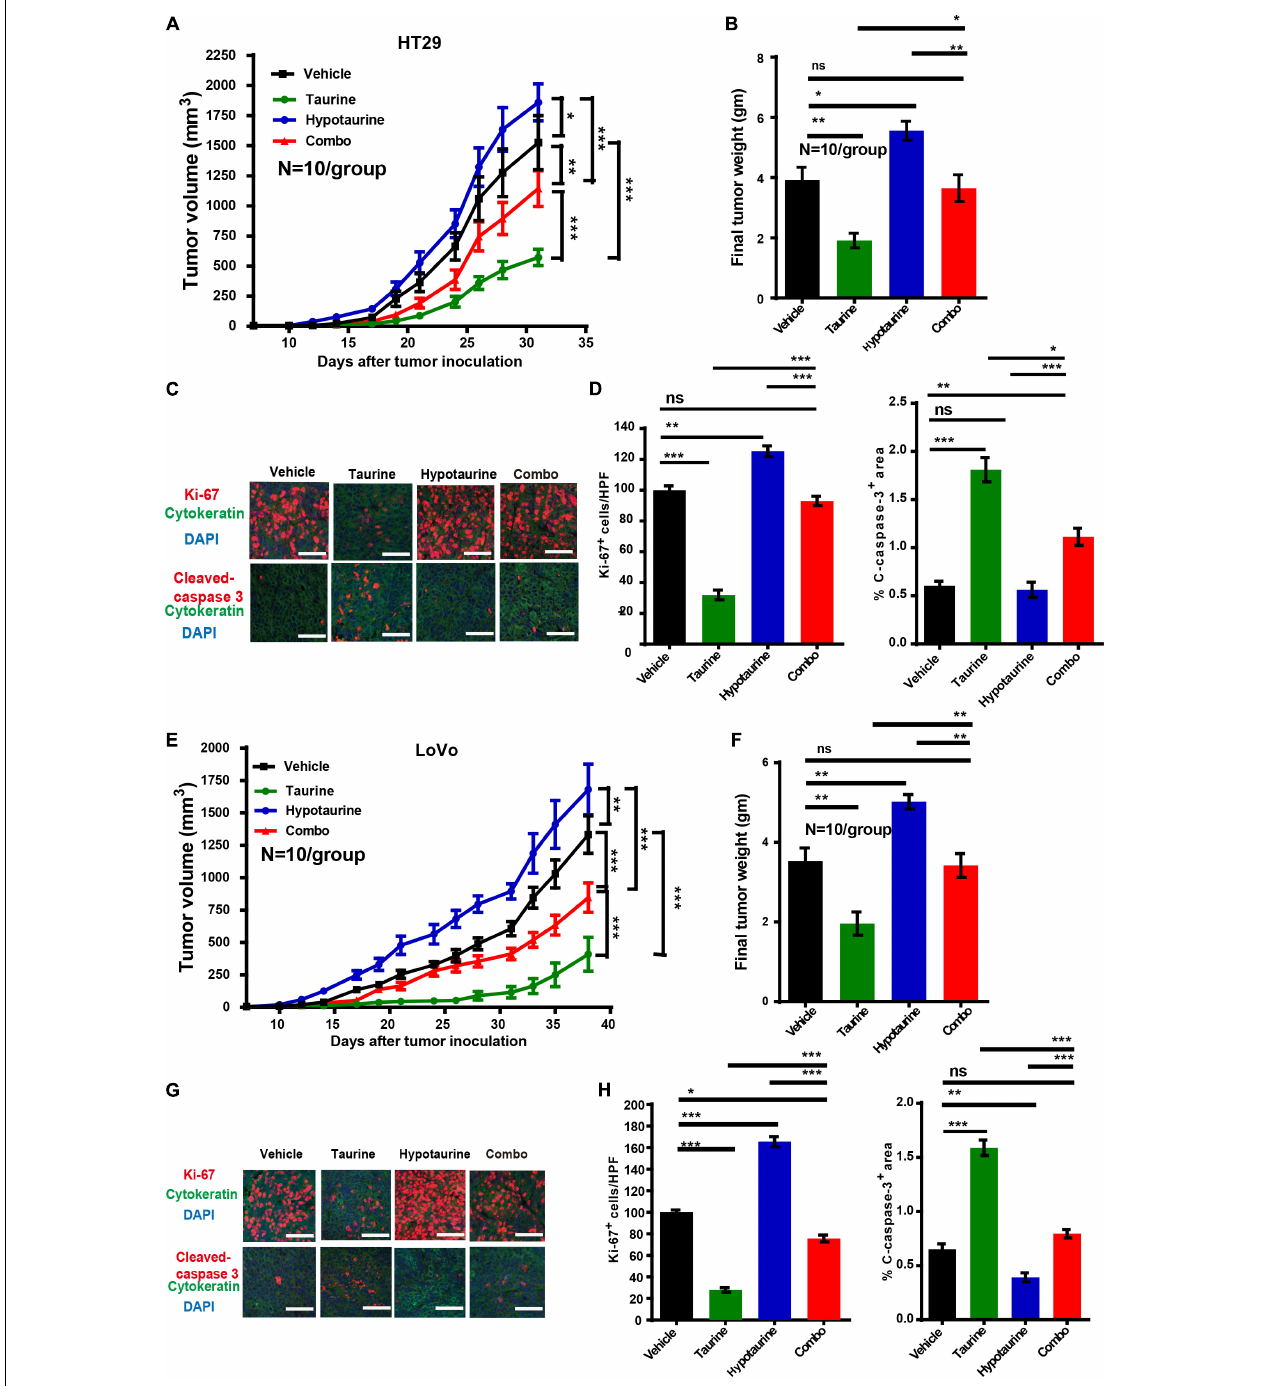
FIGURE 7 | Taurine reverses the promoting effects of hypotaurine on tumor growth in vivo . (A,B) Serial measurements of tumor volume and final weights of HT-29 tumors grown subcutaneously in nude mice treated as indicated (means ± SEM) ( N = 10/group; one-way ANOVA followed by Tukey’s post hoc test, * P < 0.05, ** P < 0.01, *** P < 0.001). (C,D) Representative photomicrographs (C) and quantification of cleaved caspase-3 + area per × 200 field and dual CK + and Ki-67 + cells per × 400 field (D) of HT-29 tumors treated as indicated using immunofluorescence. Ten random photographs were taken from each of 10 tumors per group (mean ± SEM) (one-way ANOVA followed by Tukey’s post hoc test, ** P < 0.01, *** P < 0.001; scale bars, 50 µ m). (E,F) Serial measurements of tumor volume and final weights of LoVo tumors grown subcutaneously in nude mice treated as indicated (means ± SEM) ( N = 10/group; one-way ANOVA followed by Tukey’s post- hoc test, ** P < 0.01, *** P < 0.001). (G,H) Representative photomicrographs (G) and quantification of cleaved caspase-3 + area/200 field, and dual CK + and Ki-67 + cells/400 field (H) of LoVo tumors treated as indicated and determined by immunofluorescence. Ten photomicrographic images were captured randomly from each of 10 tumors per group (mean ± SEM) (one-way ANOVA followed by Tukey’s post hoc test, * P < 0.05, ** P < 0.01, *** P < 0.001; scale bars, 50 µ m).